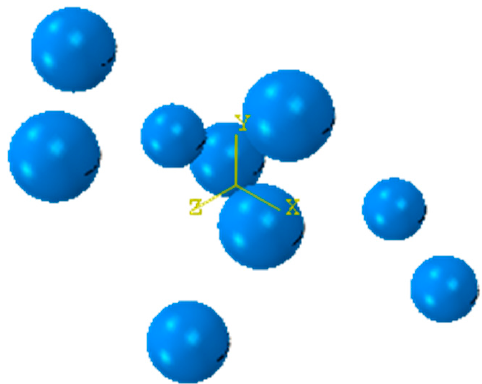
Figure 2. Distribution of reinforcing material in the RVE.